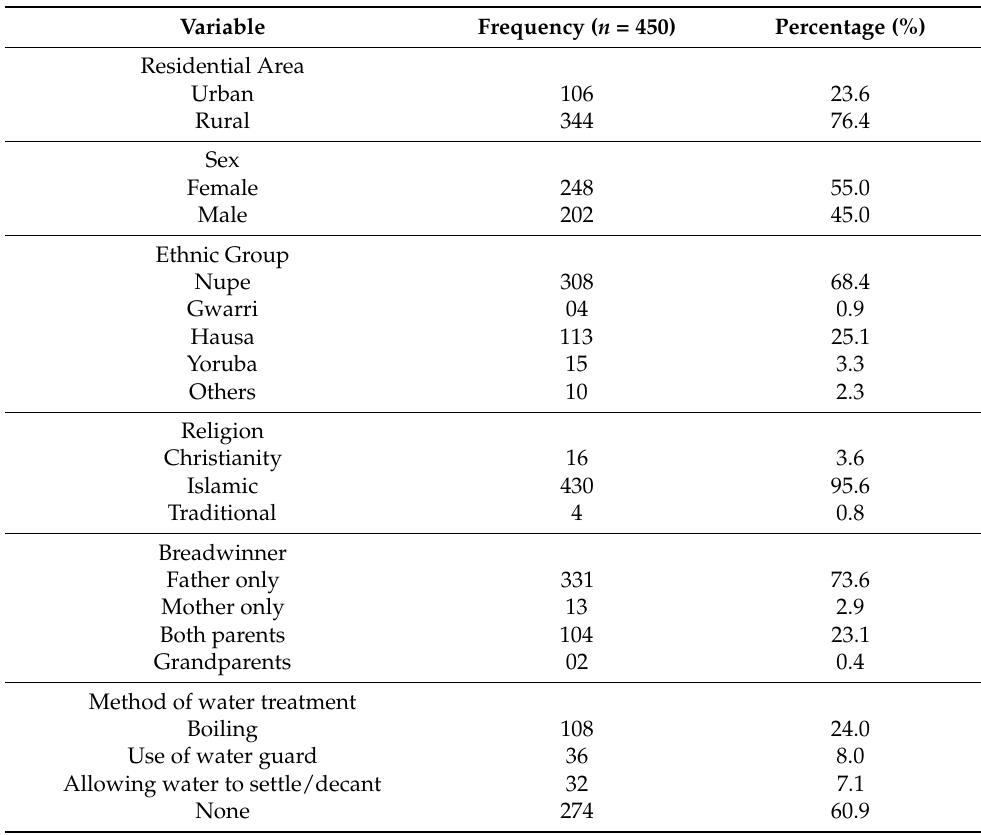
Table 1. Sociodemographic characteristics of the preschool children in Niger State.